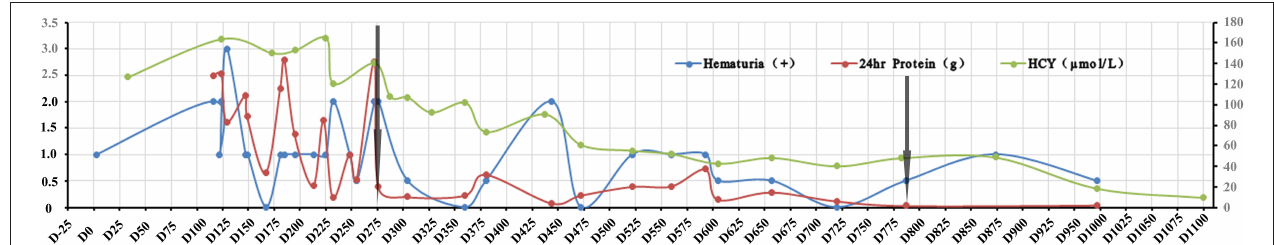
FIGURE 2 | Changes in hematuria, proteinuria, and serum homocysteine during treatment. The X-axis indicates the time points of treatment and follow up, the left Y-axis represents the 24-h urine protein and hematuria, and the right Y-axis represents the serum homocysteine concentration. The green curve denotes the serum homocysteine concentration, the red curve represents hematuria (0.5 indicates + –, 1 indicates + , 2 indicates ++ , and 3 indicates + + + ), and the blue curve represents the 24-h urine protein. The left arrow indicates the time of initial OHCbl treatment, and the right arrow indicated the time of revised treatment.